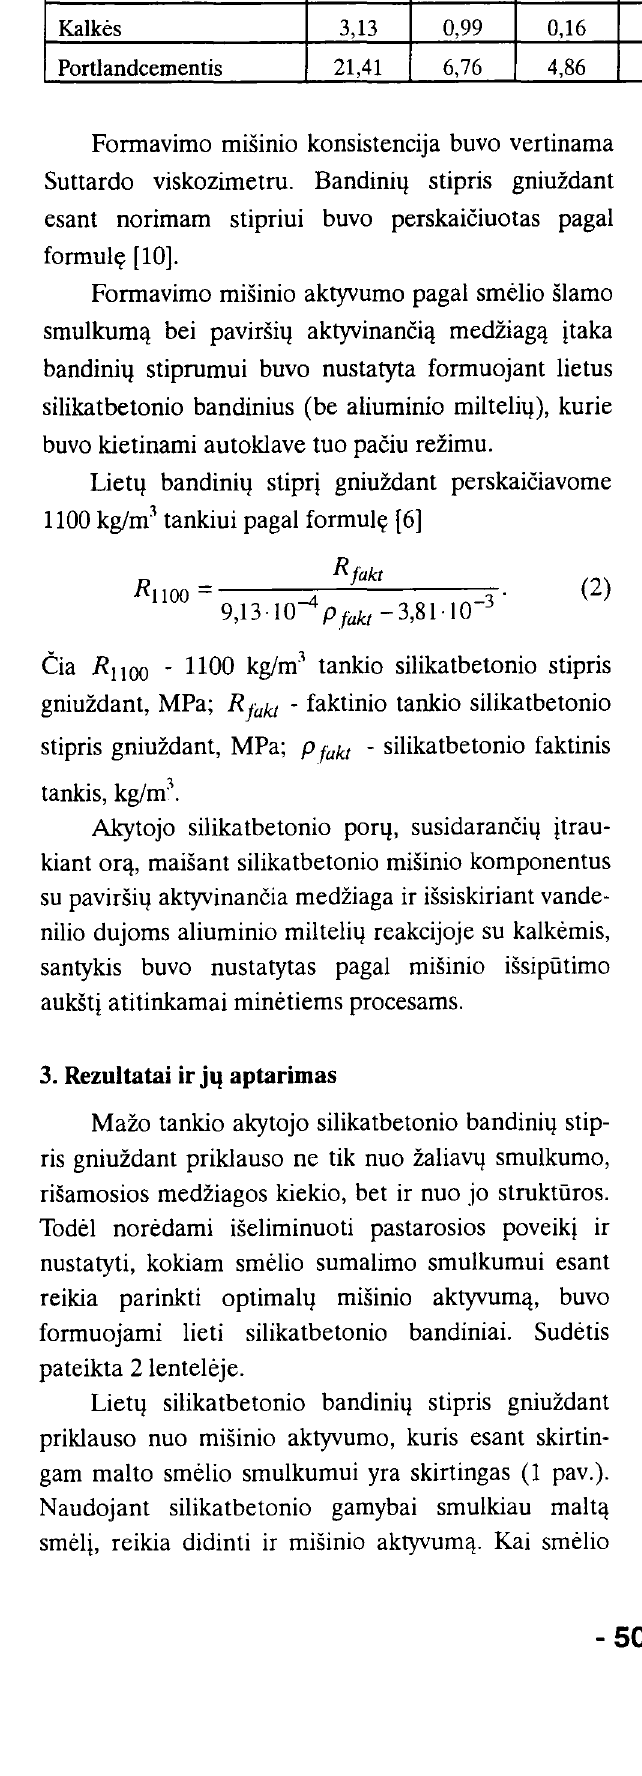
Si02 Al 0 3 Fe20, 2